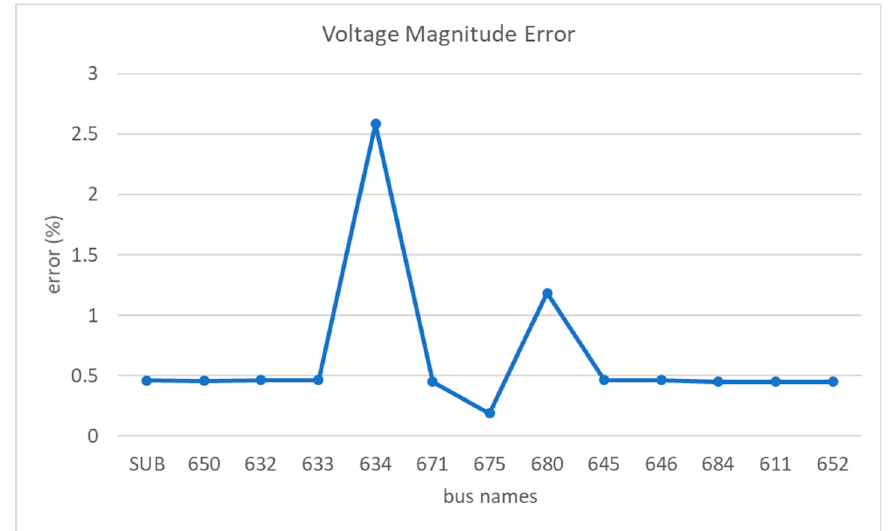
Figure 10. Voltage magnitude error in 13-bus distribution network for the second loading condition.